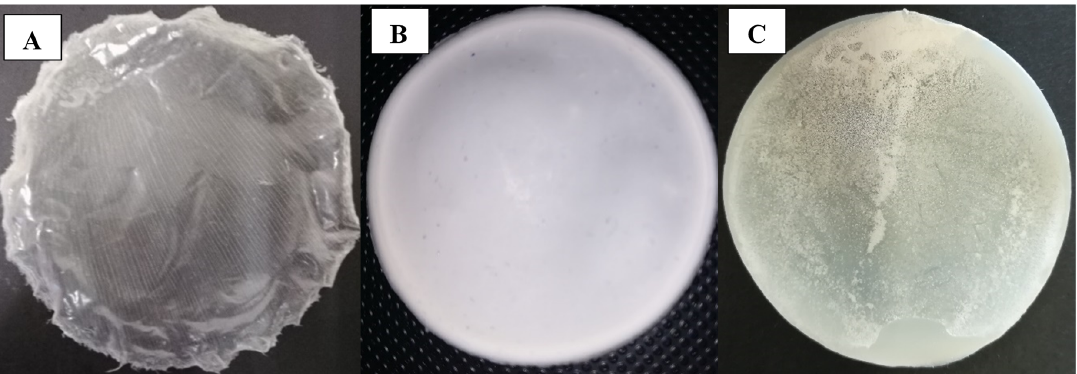
Figure 5. mcl-PHA ( A ), P(3HB) ( B ), and P(3HB) / mcl-PHA blend ( C ) films obtained by the solvent evaporation method (image A is reproduced with permission from Rebocho et al. [21]).